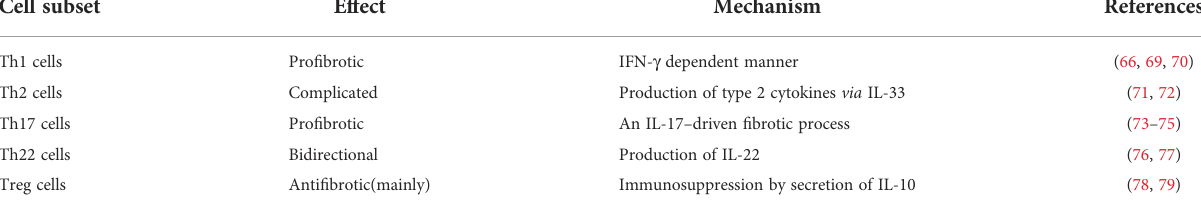
TABLE 1 Roles of diverse CD4 + T cell subsets in